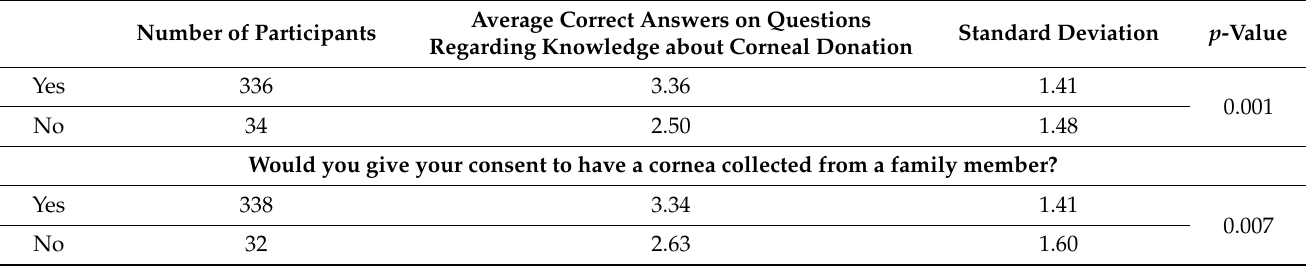
Table 4. Association between willingness to donate corneal tissue and socio-demographic data in health professionals. Would You Consent to Being a Cornea Table 3. Association between correct answers to questions regarding knowledge about corneal donation and willingness to donate. The column entitled ‘Average correct answers’ presents the number of correct answers on questions about corneal donation. Knowledge was measured by the number of correct answers.